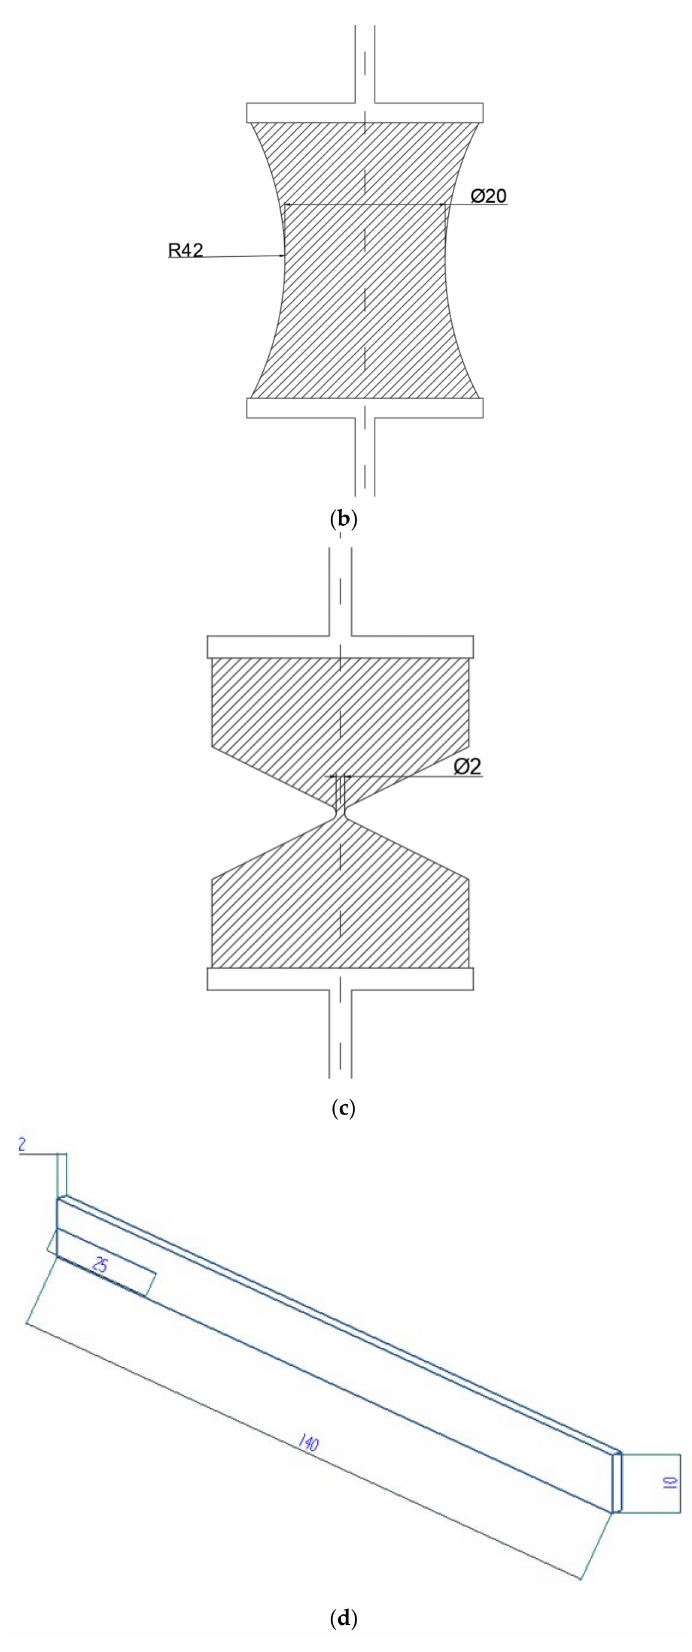
Figure 3. Rubber fatigue specimens: ( a ) dumbbell-shaped specimen; ( b ) diabolo-shaped specimen; ( c ) diabolo-shaped specimen; ( d ) torn